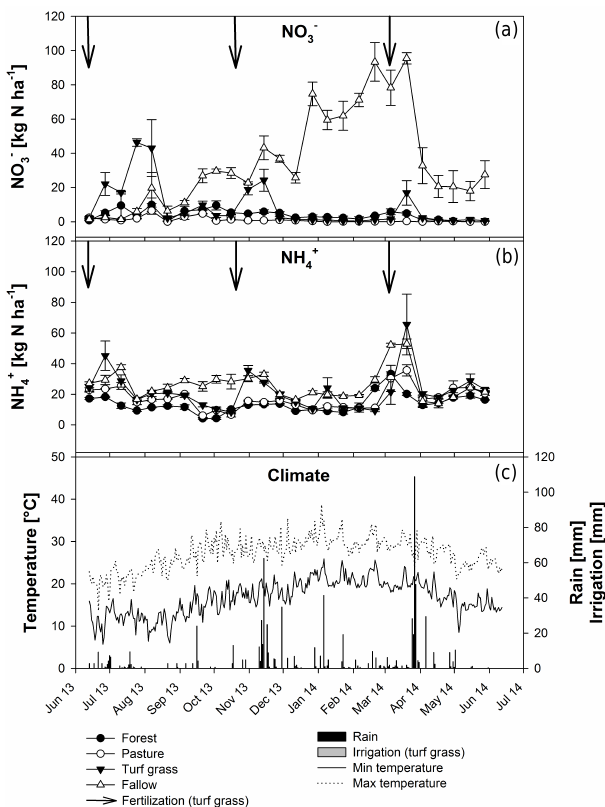
Figure 1. Annual soil NO − (a) and NH + (b) content variations 3 4 from forest, pasture, turf grass, and fallow averaged across repli- cates ( n = 3) and summed for separate analysed soil depths of 0–10 and 10–20cm with the climatic conditions (c) for the experimental year 2013 / 2014 as well as fertilisation and irrigation indication for the turf grass